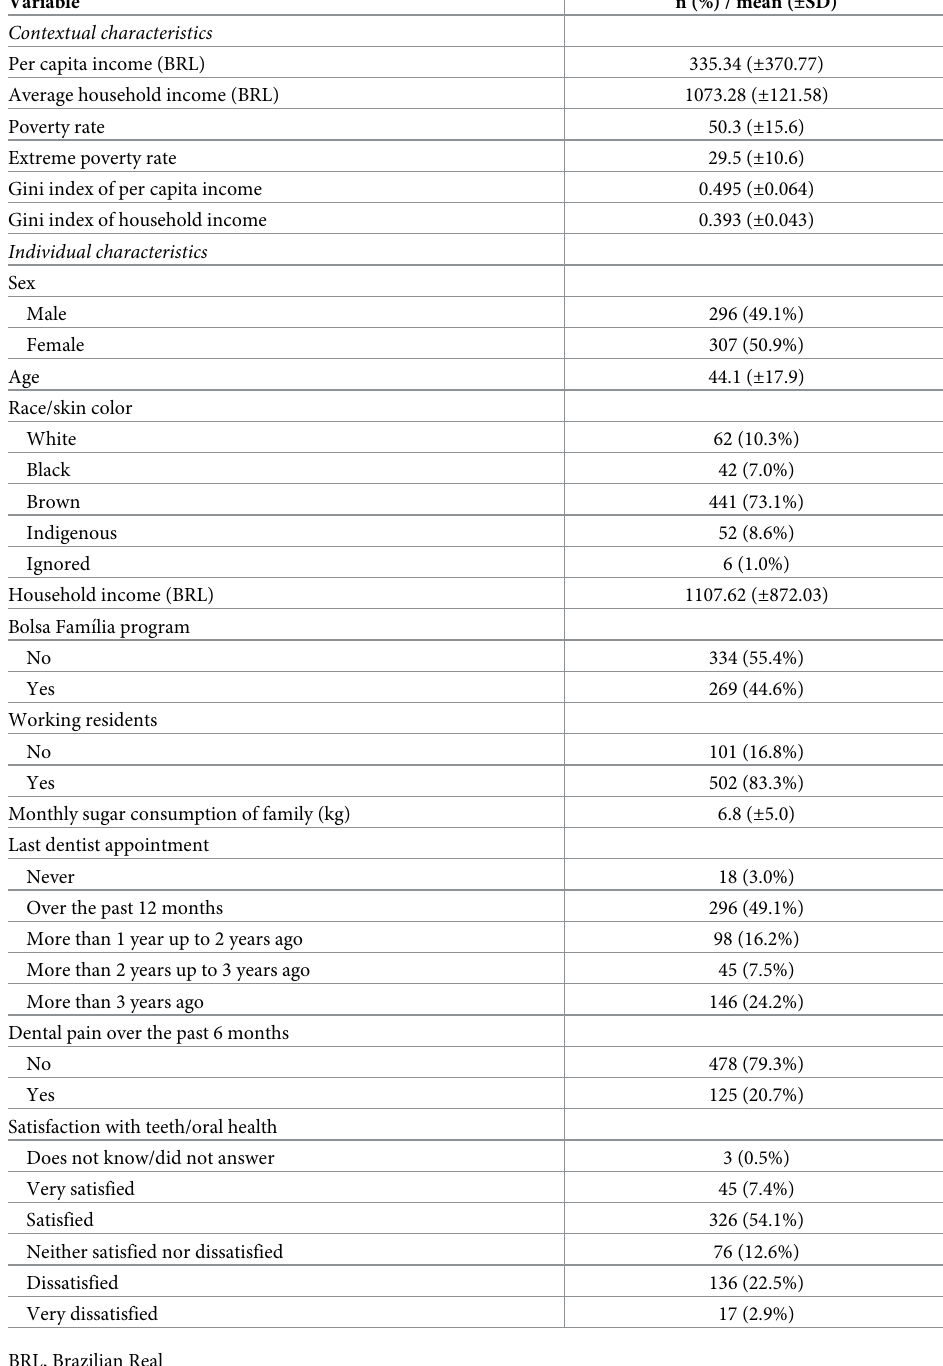
Table 1. Contextual and individual characteristics of adults and elderly residents in rural riverside localities included in the study, Negro River, Manaus, Amazonas,